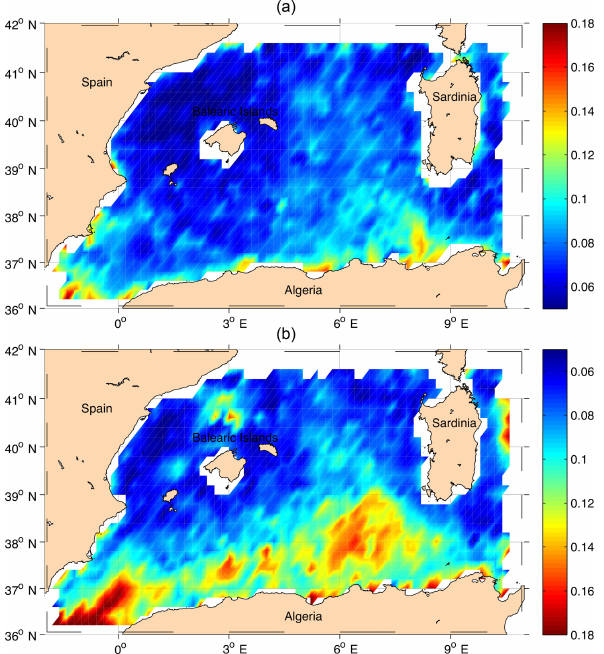
Figure 6. Absolute value of the mean relative vorticity normal- ized with respect to the Coriolis parameter ( f ), ξ/f , of the cy- clonic (a) and anticyclonic (b) structures from January 1993 to De- cember 2016 with a grid resolution of 1 / 5 ◦ . The largest vorticity (in absolute value) is associated with anticyclones south of 39 ◦ N.